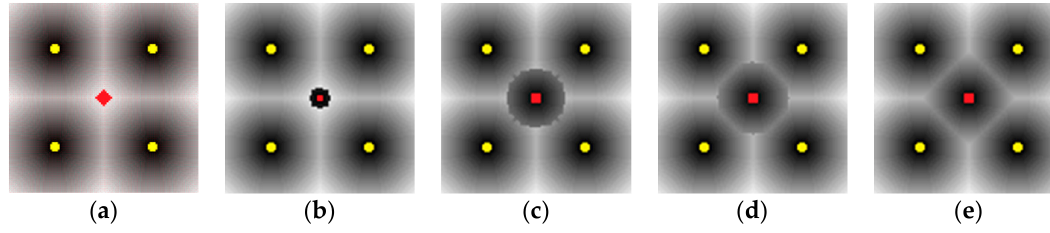
Figure 4. Lower wavefront propagation. ( a ) Insert a new obstacle cell; ( b ) Launch a lower wavefront; ( c ) Propagate the distance change; ( d ) Reach edges of affected area; ( e ) New DM is reconstructed.